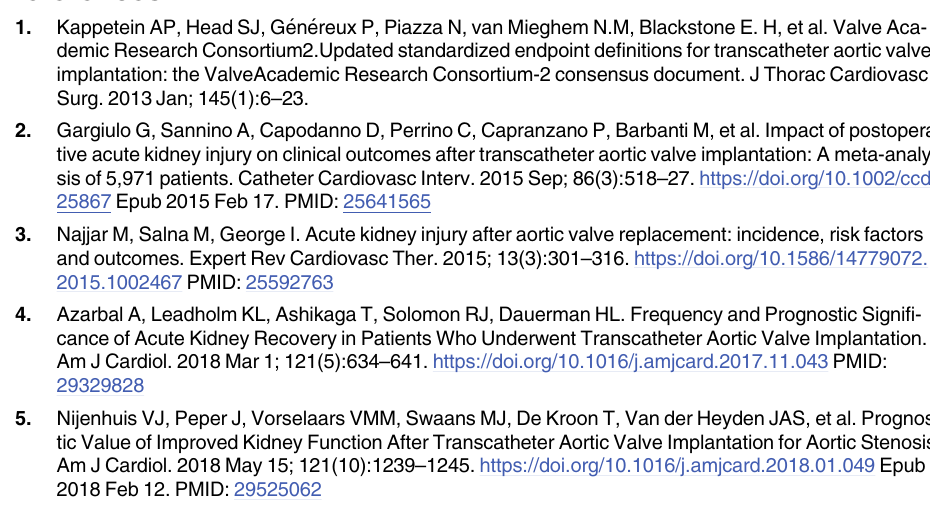
S1 Table. AKI. AKR and unchanged renal function according to the time of